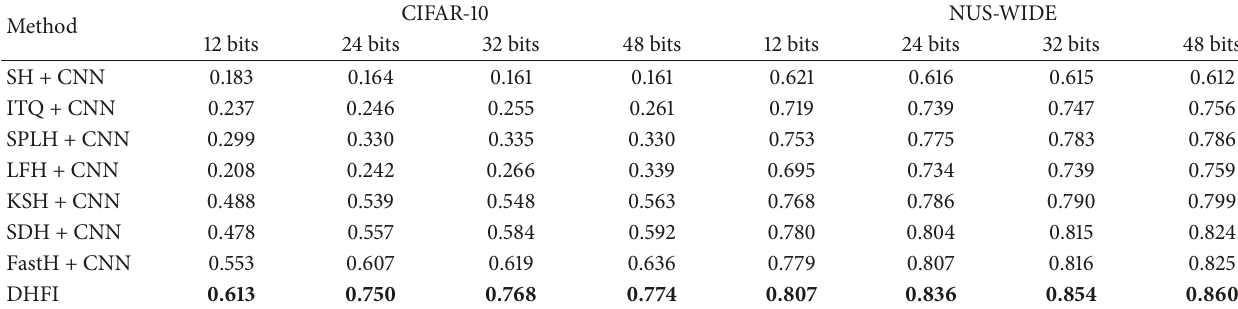
Table 3: Accuracy in terms of MAP compared to nondeep methods with deep